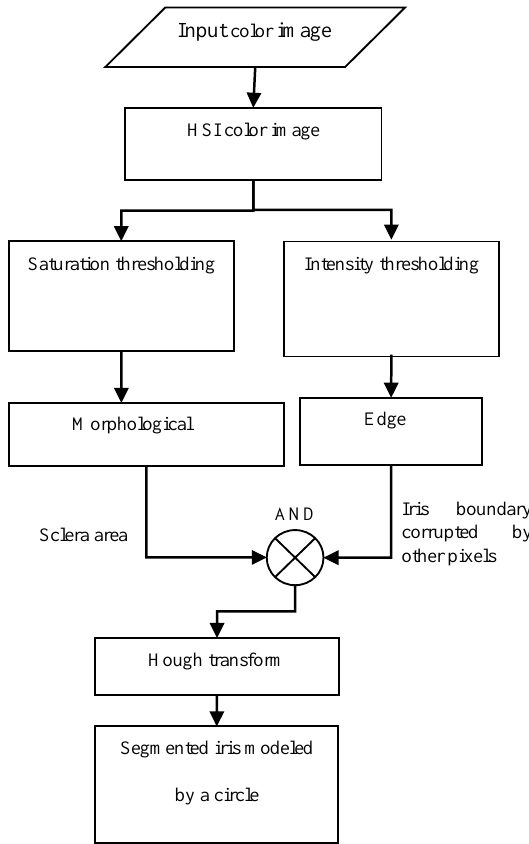
Figure 1. Flow diagram of proposed iris segmentation